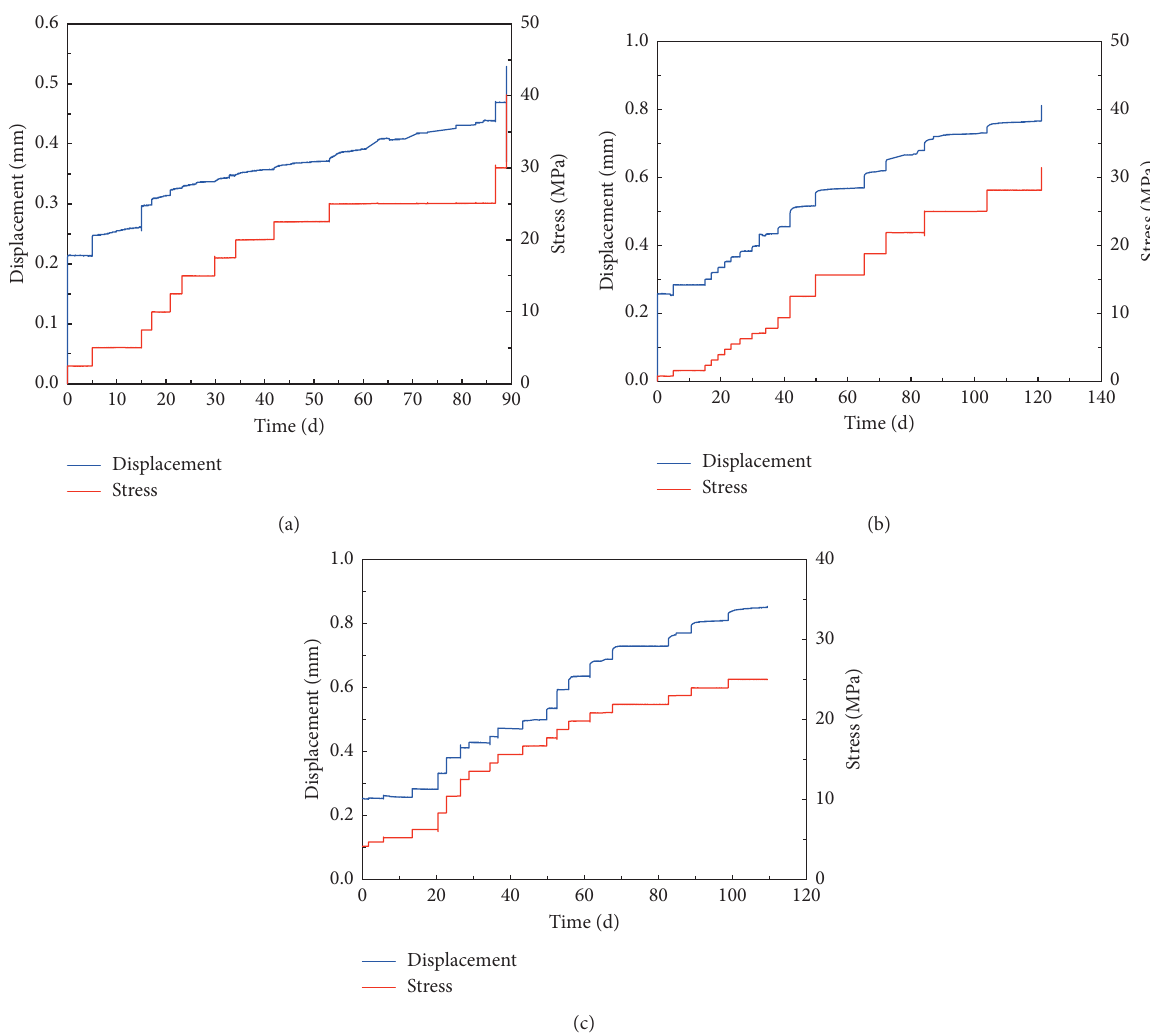
Figure 5: (a) Creep curve of the medium-grained sandstone. (b) Creep curve of the untreated CGB. (c) Creep curve of the CGB soaked in